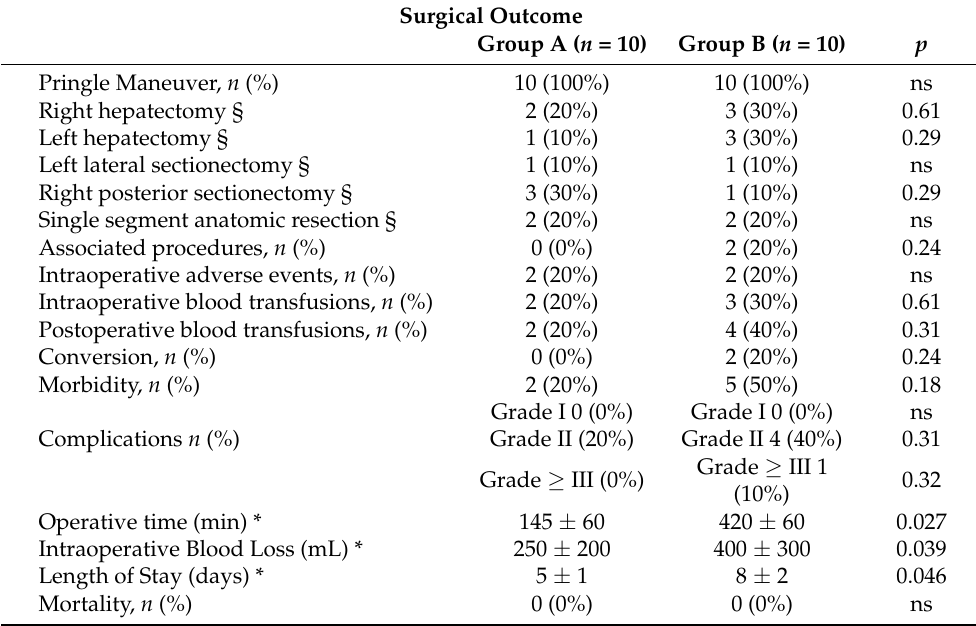
Table 3. Surgical